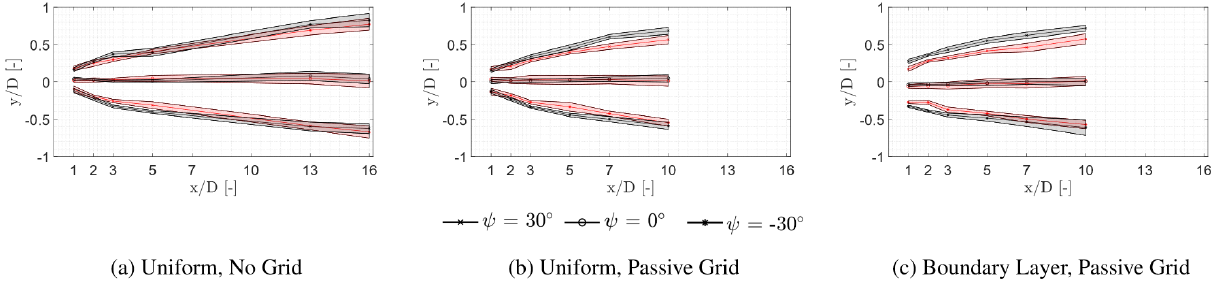
Figure 11. Wake deflection at different inflow condition determined with the methods described by Schottler et al. (2018). The wake centre is derived from the vertical scans at each downstream distance. The shaded area indicates the spread of the wake centre determined for each individual vertical scan. Black: Gaussian method. Red: minimal potential power method.